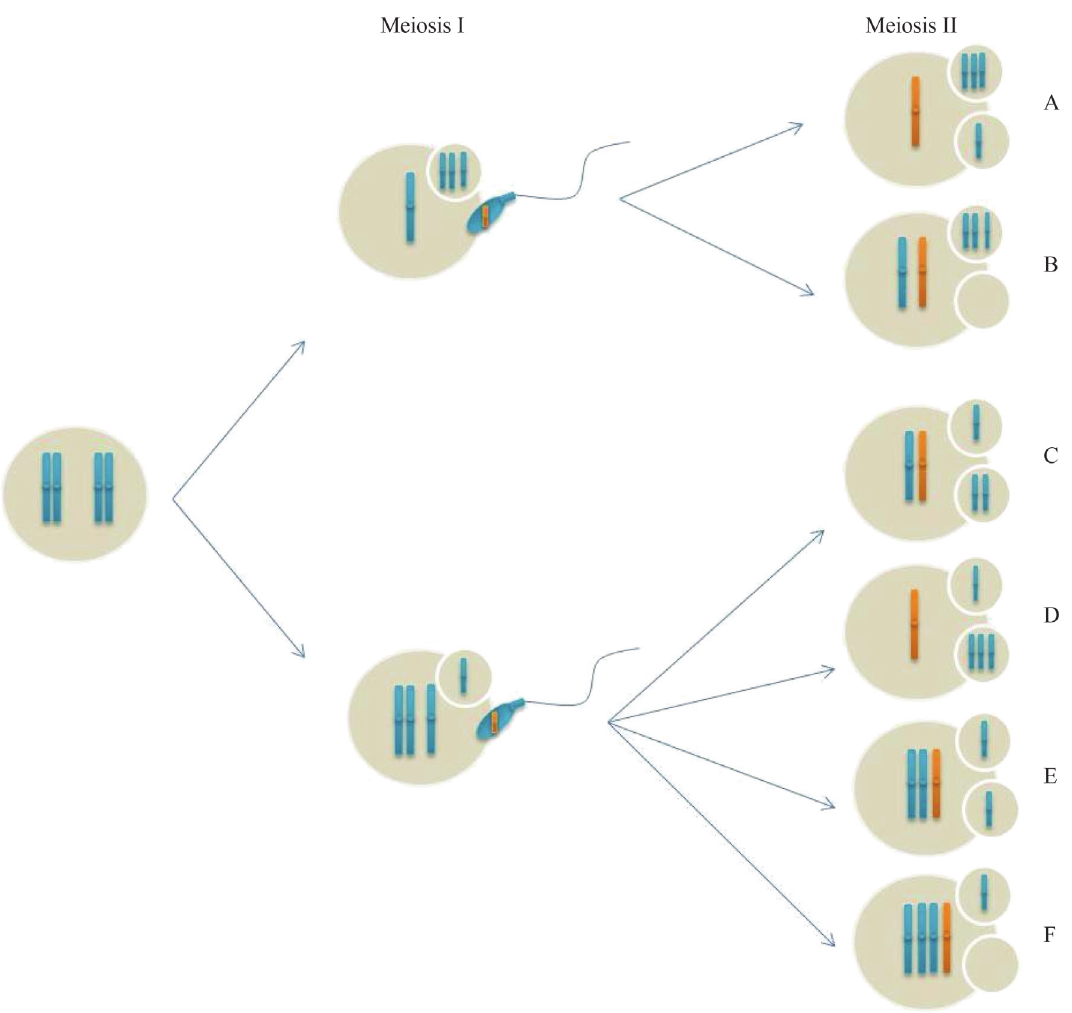
Figure 3 - Possibilities of segregation during second division from an abnormal oocyte by early separation of sister chromatids. Two of the six possibili- ties are normal (A and B).